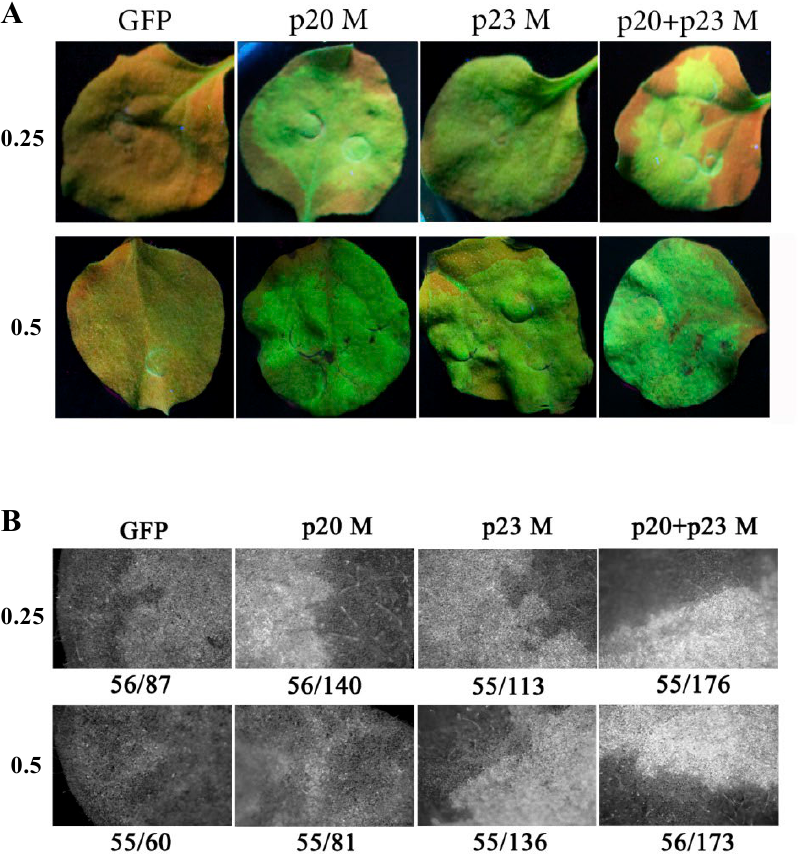
Figure 3. A. The GFP fluorescence images of the infiltrated leaves inoculated with Agrobacterium cultures at OD and 0.5 taken at 5 dpi under UV light. GFP: single infiltration with pK-GFP; p20 M, p23 M: co-infiltration of pK-GFP with the corresponding p20 or p23 constructs; p20+p23 M: co-infiltration of pK-GFP with p20 and p23 constructs of the same CTV isolate. B. Graytone images of GFP fluorescence taken under UV light with a stereo microscope from leaves at 5 dpi with the same conditions described at point A. Values below the images correspond to the ratio between red (black areas) and green (bright areas)